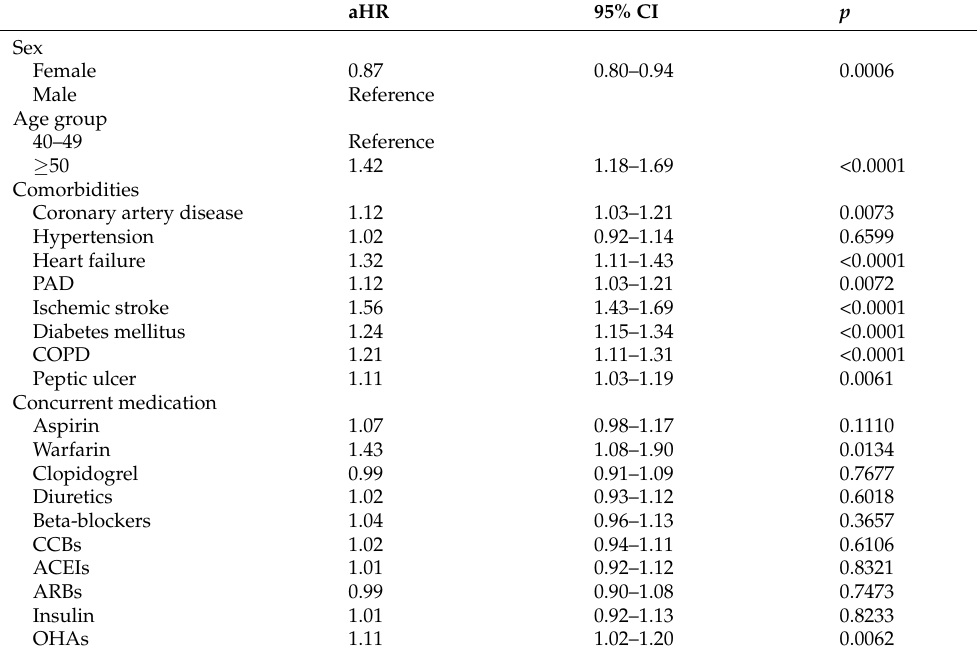
Table 4. Sub-group analysis, aHRs of dementia for use of statin.